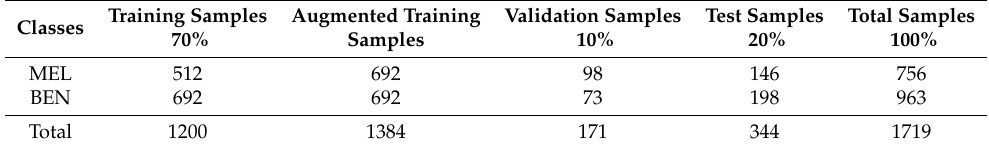
Table 1. The ISIC 2016 data distribution among training, validation, and test sets.